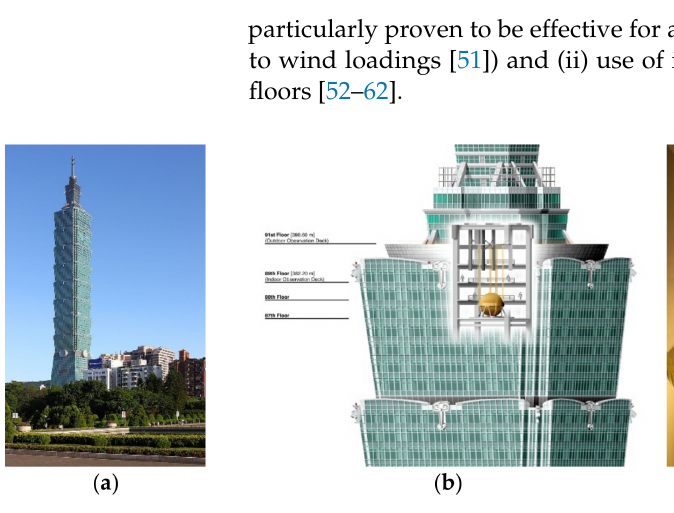
Figure 5. ( a ) Tower of Taipei 101 in Taiwan https://upload.wikimedia.org/wikipedia/commons/1/